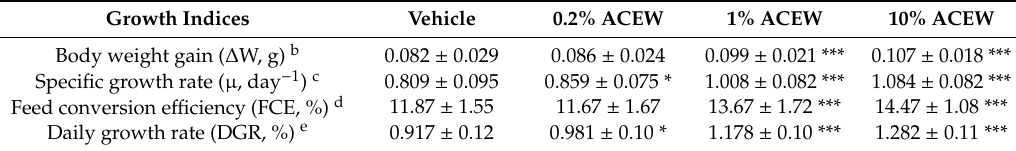
Table 1. Growth performance of zebrafish fed diets supplemented with di ff erent doses of ACEW a . Growth